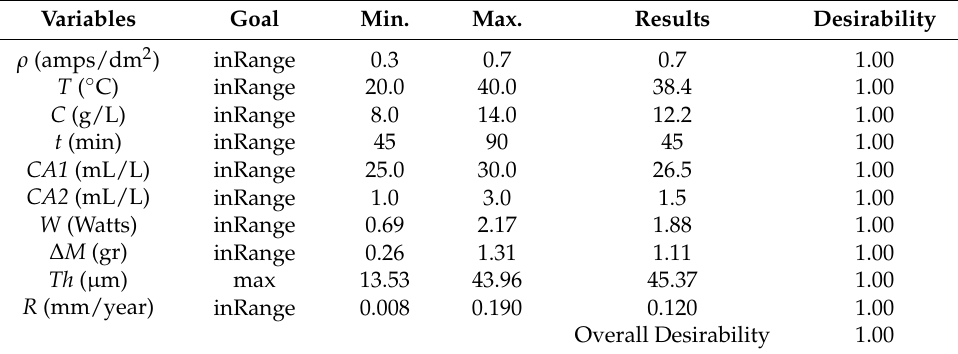
Table 13. The fourth criterion that was considered: maximizing the coating thickness ( Th ). Variables